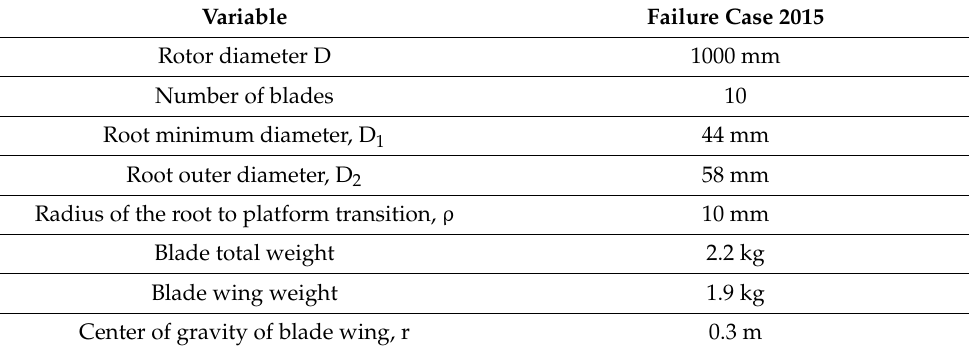
Table 1. Dimensions of the jet fan of the 2015 failure case according to the manufacturer’s